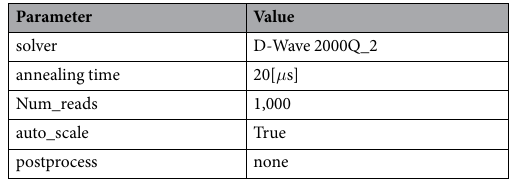
Table 2. Parameter settings of D-Wave quantum annealer.